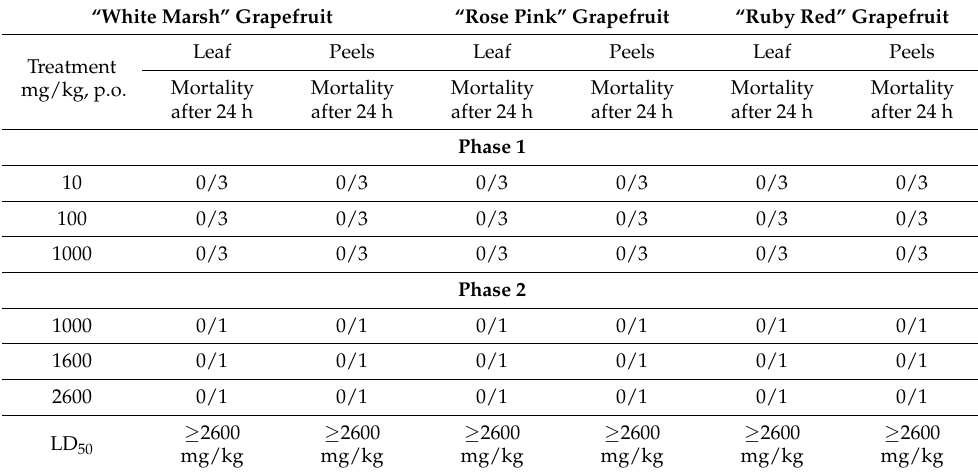
Table 3. Acute toxicity profile of the leaf and peel essential oils from three Citrus paradisi cultivars in mice.